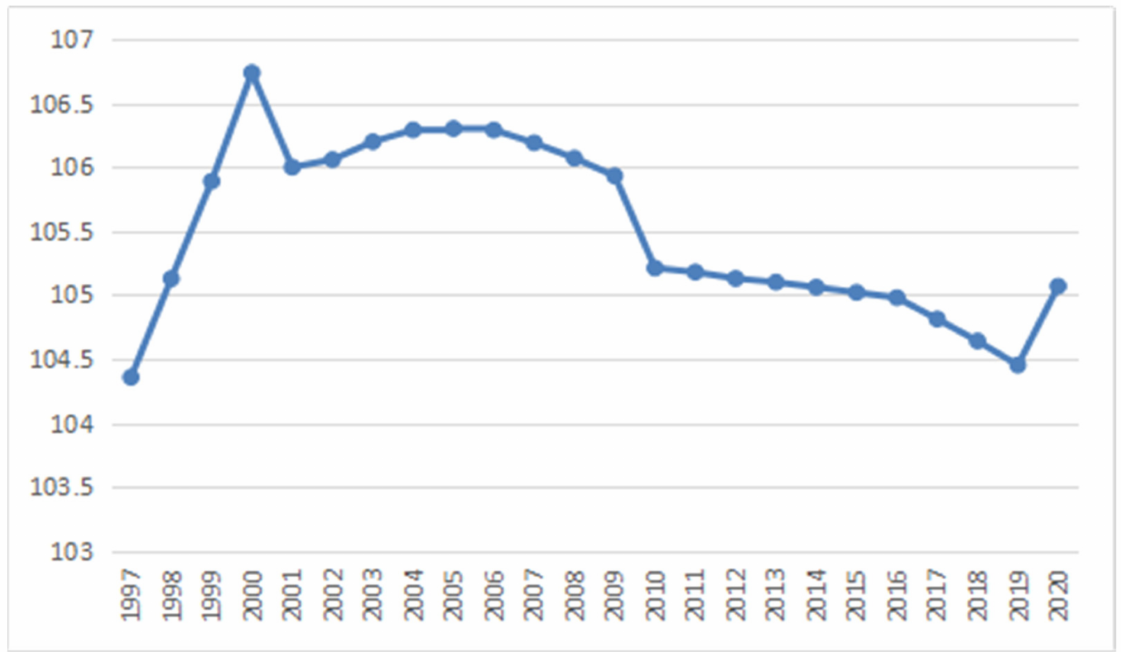
Figure 1. Gender ratio of China’s population, 1997–2020 (female =